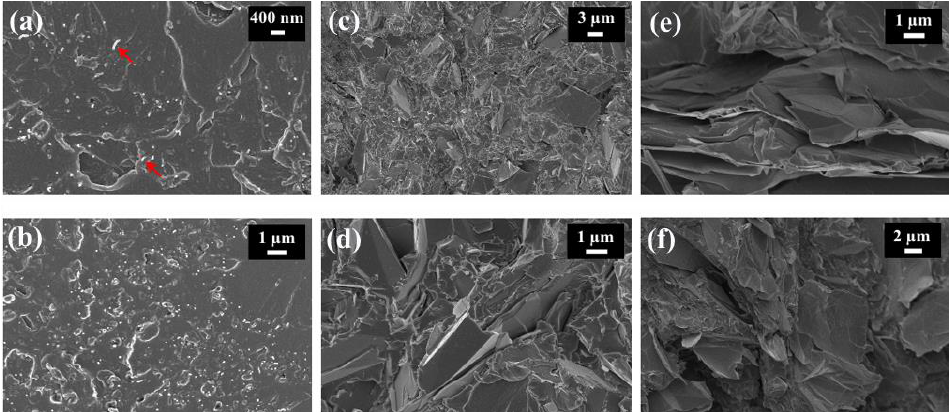
Figure 1. Fracture surface of composite with 0.2 wt.% of carbon nanotubes (CNTs) 50k× ( a ), 1 wt.% of CNT 25k× ( b ), 40 wt.% of graphite 5k× ( c ), 40 wt.% of graphite 25k× ( d ), 6 wt.% of GNP 25k× ( e ), 25 wt.% GNP 10k× ( f ).